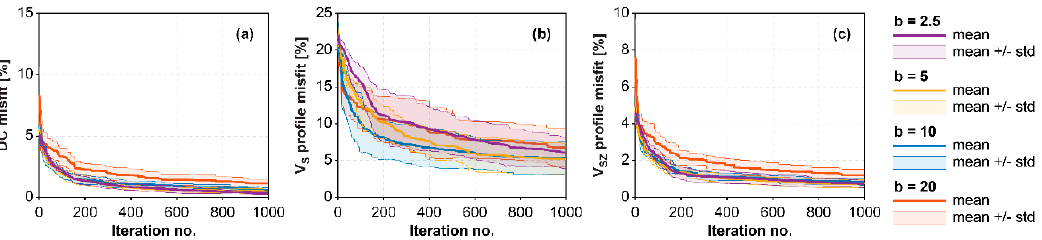
Figure 12. Model C. Data and model fitting progression for the inversion results in Figure 10.